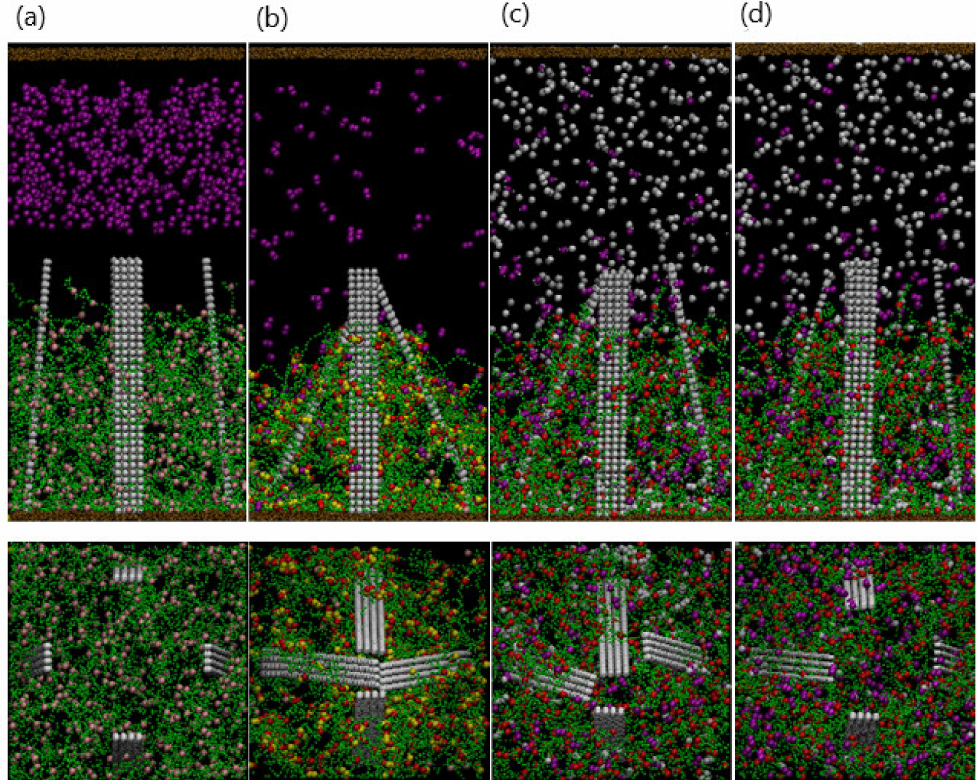
Figure 10. ( a – d ) Upper (lower) panels are top (side) view of the system with four fibers. ( a ) Addition of copper particles at t = 0. ( b ) Fibers clasp at t = 2 × 10 6 . ( c ) Snapshot at t = 2 × 10 5 after adding EDTA particles. ( d ) Fibers open at t = 2 × 10 6